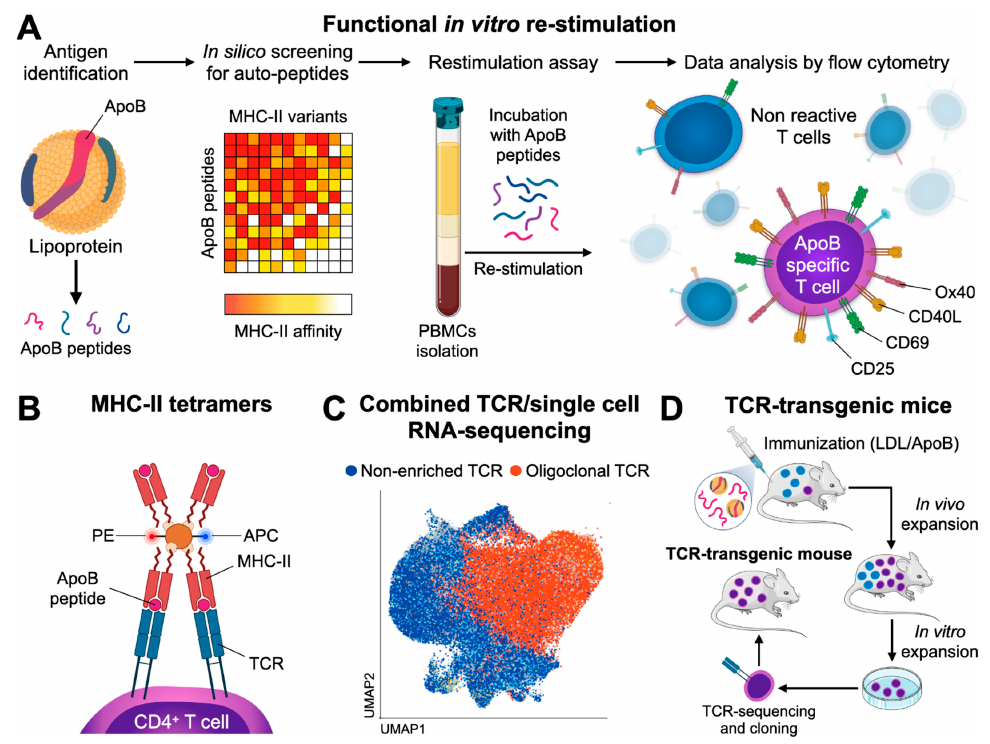
Figure 1. Approaches to detect Apolipoprotein B (ApoB)-specific CD4 + T cells in mice and humans. Functional restimulation with ApoB-peptides requires a peptide mapping of the entire ApoB-sequence and a selection of peptides with the highest predicted and tested affinity towards the MHC-II complex. Antigen-presenting cells are loaded with selected peptides and co-incubated with CD4 + T cells. Expression of activation markers is subsequently used to identify activated, ApoB-reactive T cells ( A ) Design of tetramers of MHC-II loaded with the peptide of interest. Tetramers are labelled with fluorochromes for the detection of tetramer-binding T cells in flow cytometry. ( B ) In simultaneous T cell receptor (TCR) and gene expression RNA-sequencing, T cells with an oligoclonal repertoire of the TCR are detected on a single cell level, which allows to selectively analyze gene expression in these cells. ( C ) Workflow for the generation of a TCR-transgenic mouse: peptide-specific T cells are expanded in vivo by immunization with LDL or a self-peptide from ApoB, isolated, and further expanded ex vivo by restimulation with LDL or peptide-loaded APC. Resulting clones undergo TCR-sequencing and the most promising TCR-sequences are used as templates for the generation of a TCR-transgenic mouse ( D ).